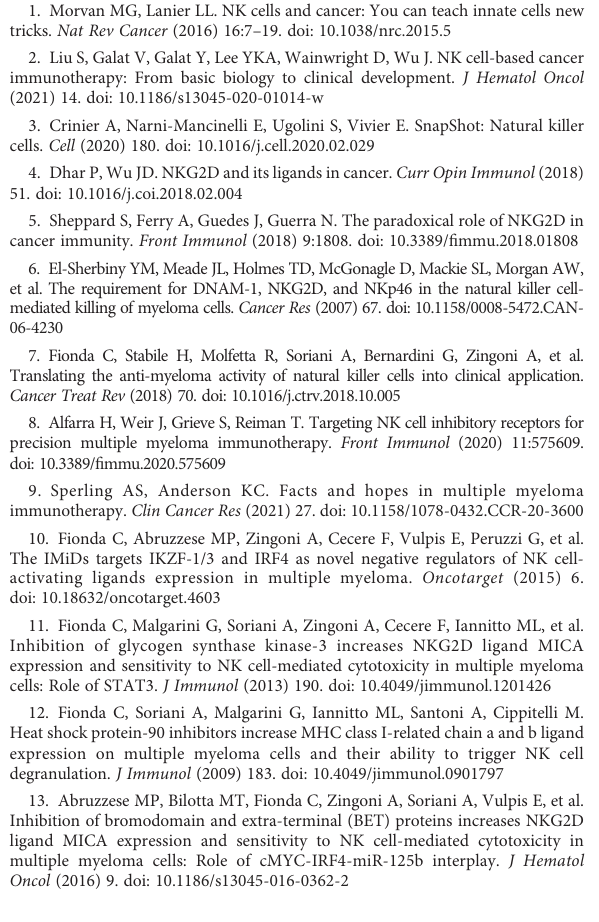
SUPPLEMENTARY TABLE 1 Clinical parameters of MM patients used for the analysis of GAS6 in condition medium derived from BMSCs and BM plasma. Patients were classi fi ed according to Durie and Salmon ’ s Staging System.